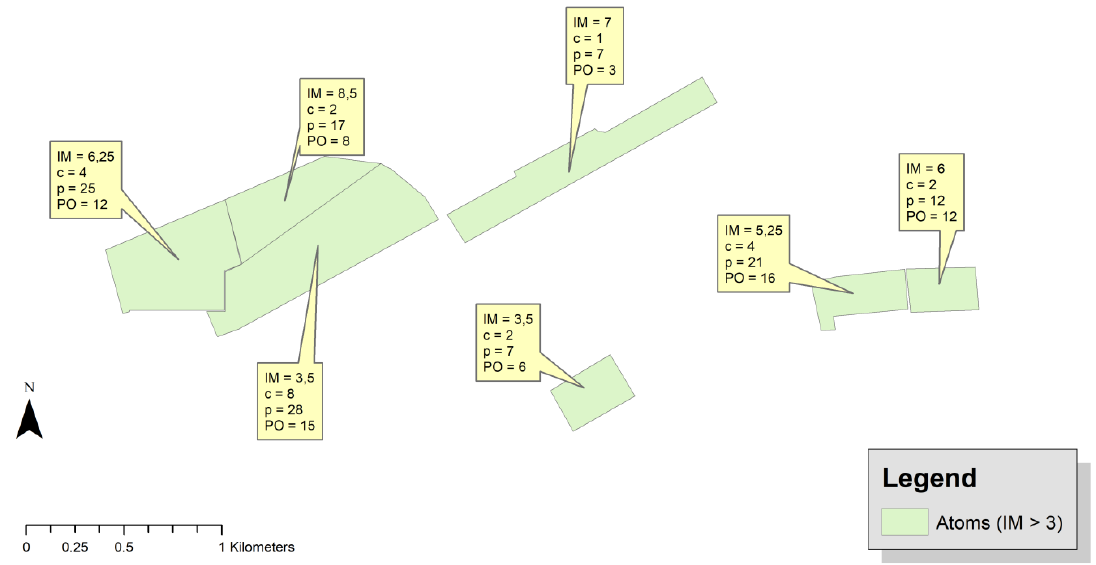
Figure 4. Atoms with IM > 3 (c — the number of crimes inside the atom, p — the number of police perceptions inside the atom, PO — the number of police officers who placed their perceptions inside the atom).